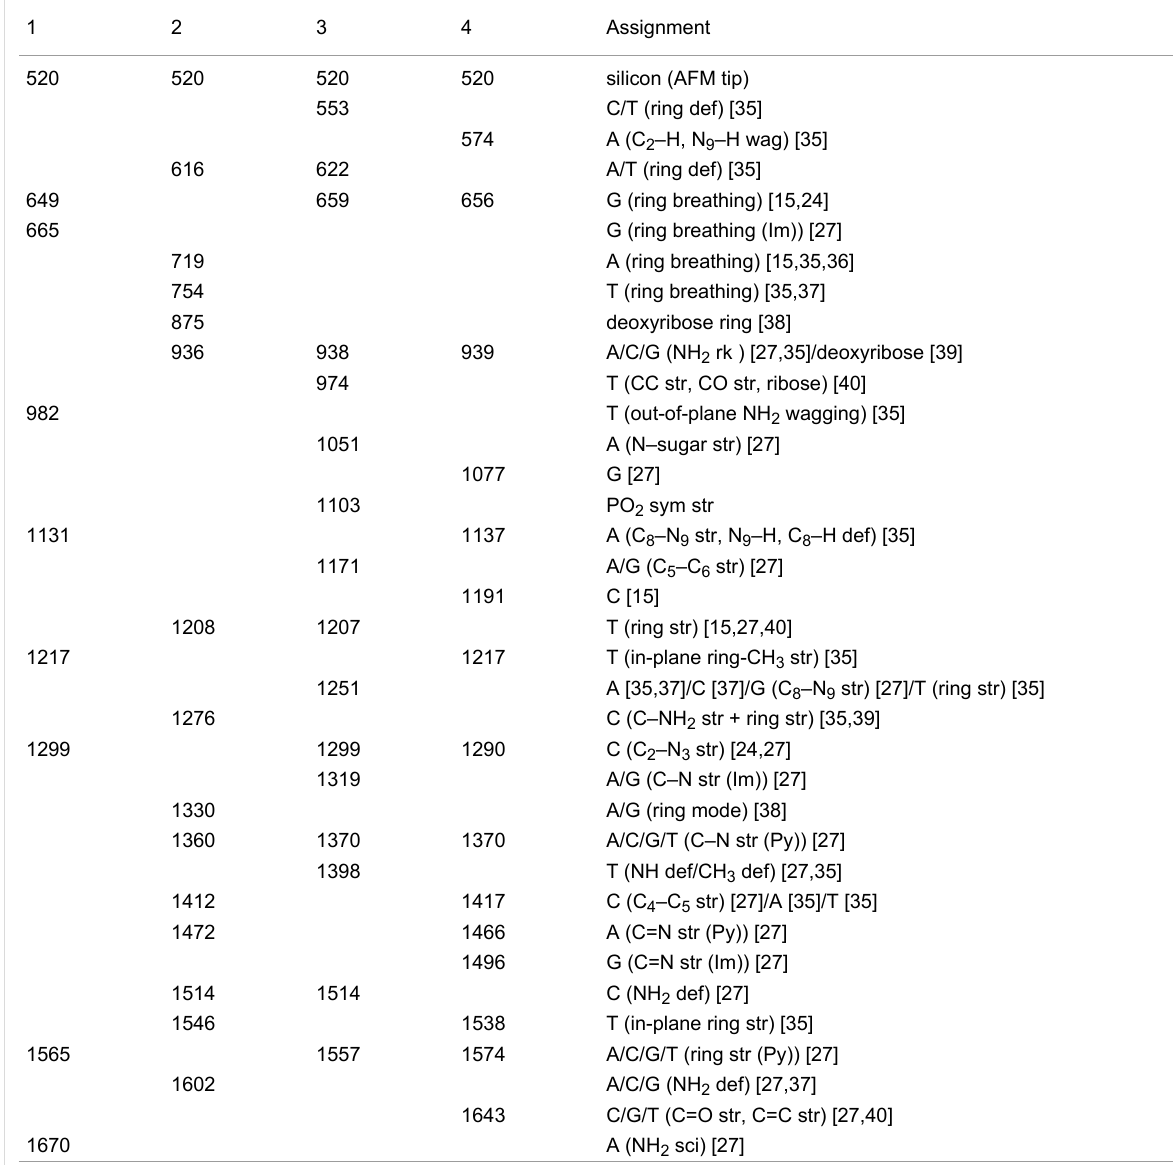
Table 3: Band assignment of the TERS spectra of the calf thymus DNA (cm − 1 ).